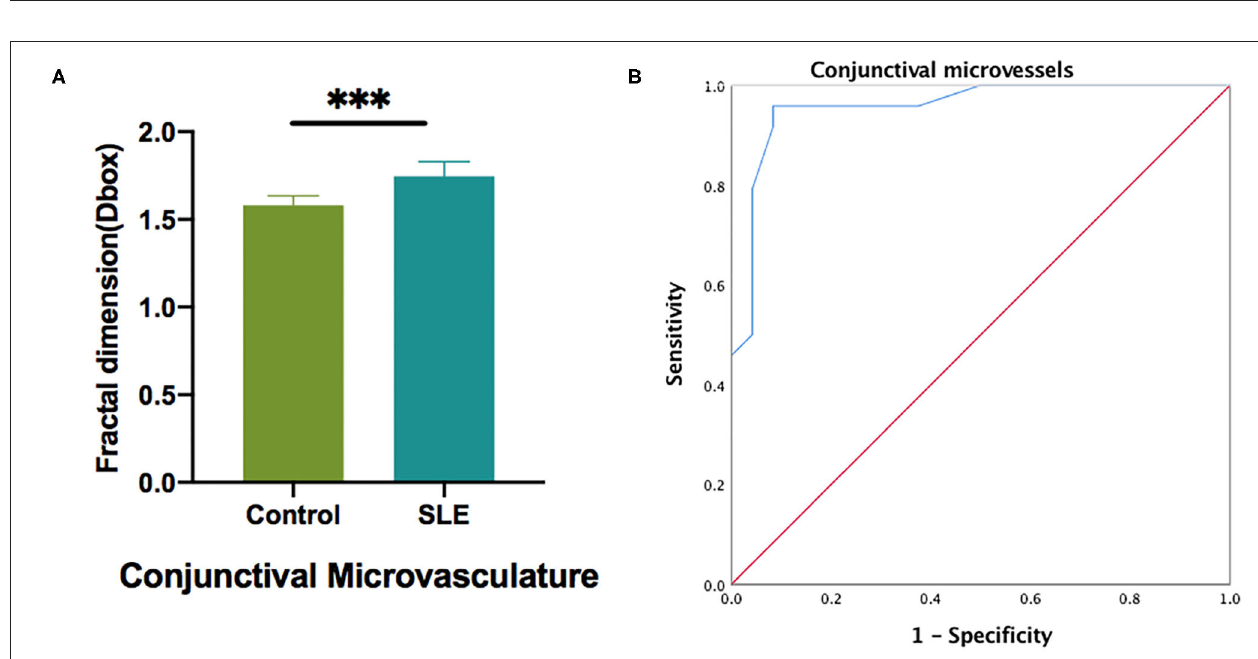
FIGURE 6 | The conjunctival microvascular density analysis of control and SLE groups. (A) Statistic analysis of conjunctival microvascular in two groups; (B) The ROC curve analysis of conjunctival microvascular density. *** P < 0.001.